Question: In a single sentence, describe what this figure presents.
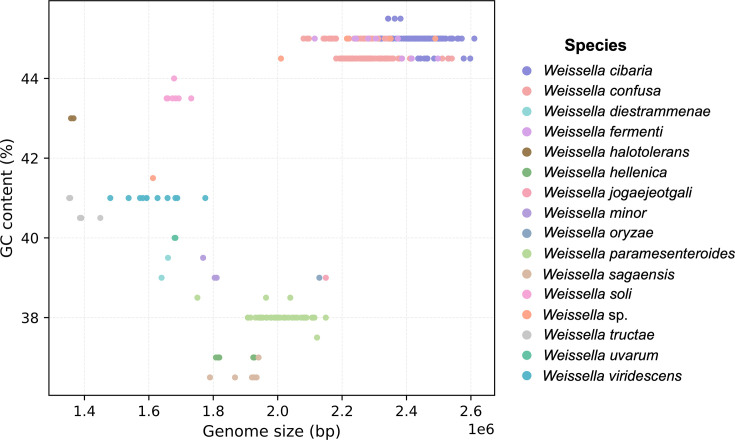
Answer: Genome size and GC content of Weissella genomes from the NCBI data set. Scatter plot of 347 Weissella genomes showing species-specific clustering patterns across genome size (1.35–2.61 Mbp) and GC content (36.58%–45.50%). Each dot represents one genome, colored by species.